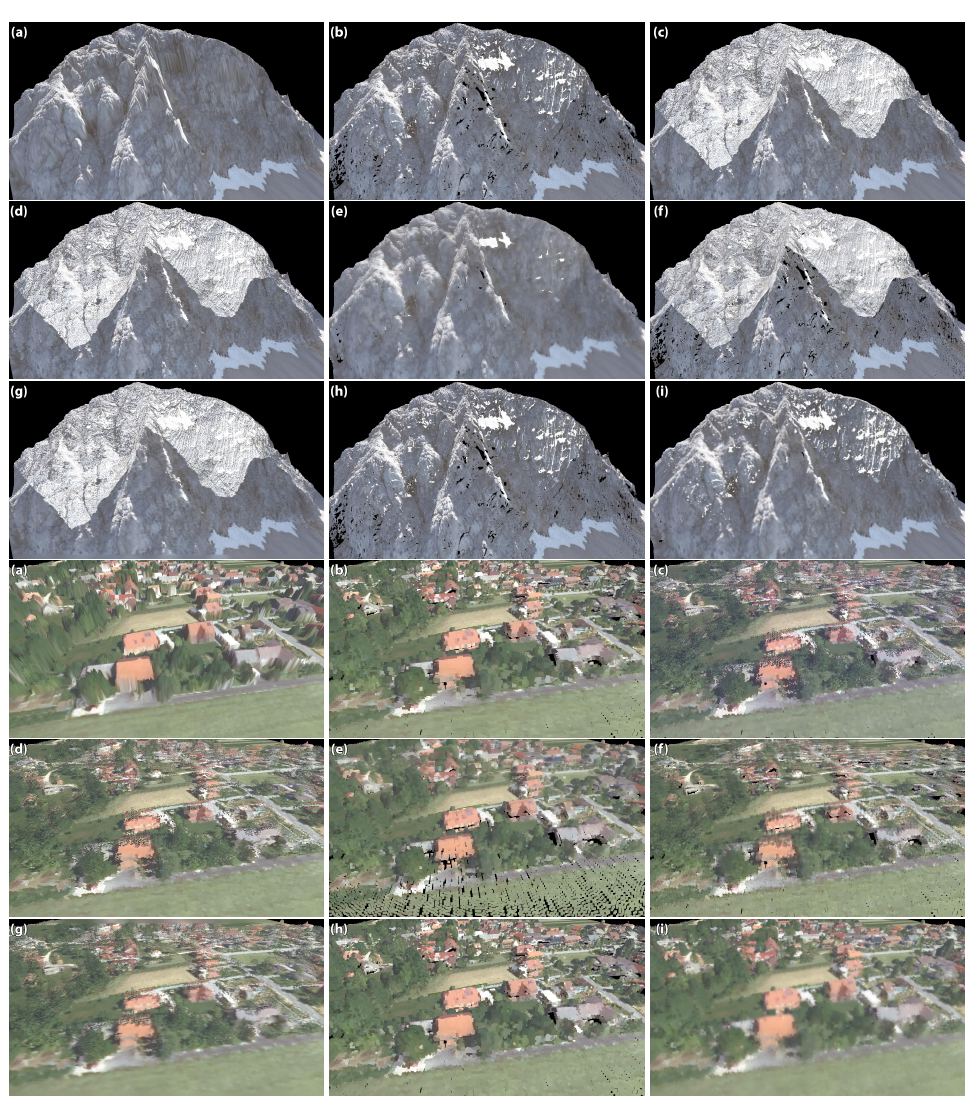
Figure A2. Additional rendering results of the presented rendering methods for high mountain scene ( top ) and residential region with houses and trees ( bottom ) : ( a ) mesh; ( b ) fixed points; ( c ) nearest neighbor; ( d ) jump flooding; ( e ) inverse distance weighted; ( f ) inverse distance weighted with splats; ( g ) natural neighbor; ( h ) paraboloids; and ( i ) our